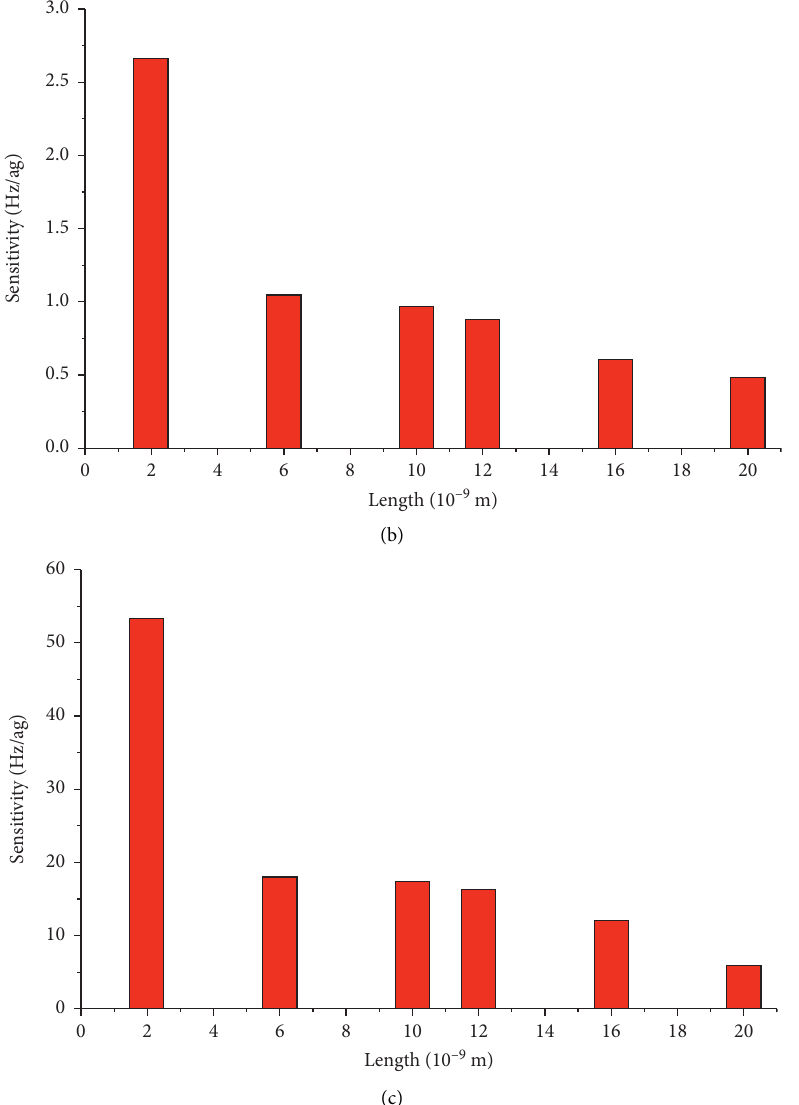
Figure 12: Fixed-free boundary sensitivity analysis for (a) insulin, (b) IgG, and (c) LDL biological objects mass